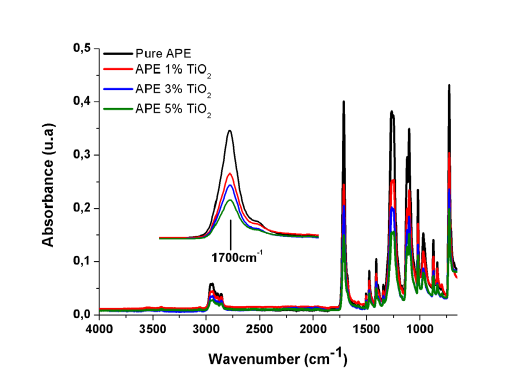
Fig. 1. FTIR Spectra of the pure APE, APE/TiO with 1%, 3%, 5% of TiO